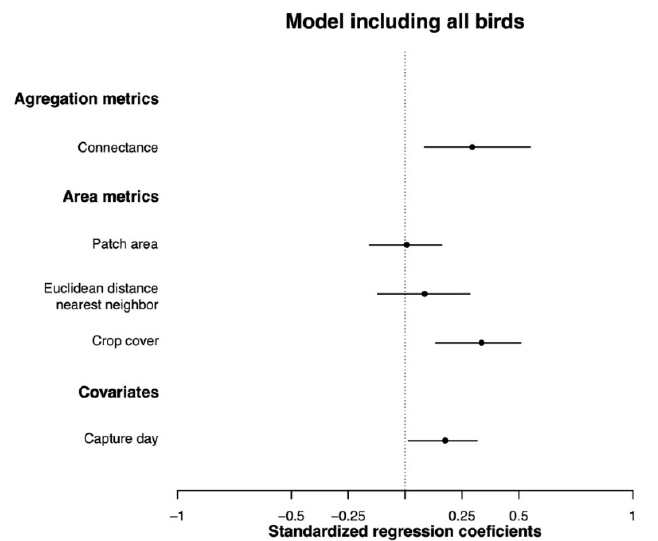
Figure 2. Standard regression coefficients obtained from the BLMM model, including all bird species. The dot represents the posterior mean, and the lines represent confidence intervals of 95%. We consider a given variable to have a statistically significant effect on body condition when the confidence intervals do not overlap with zero.